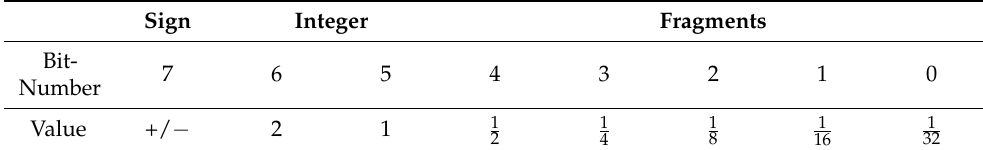
Table 3. Q7 datatype in the hardware